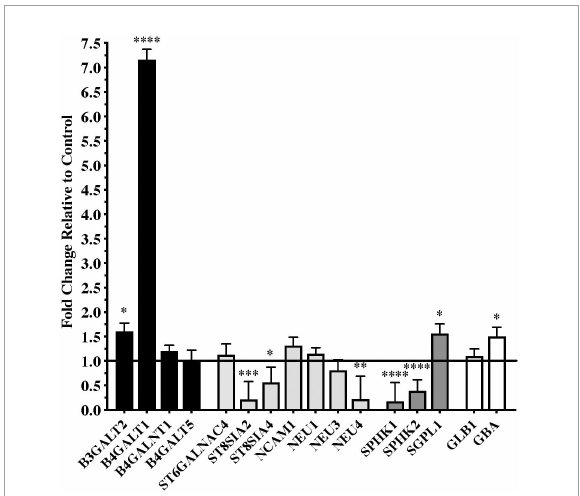
FIGURE1 Gene expression changes in substantia nigra from patients with Parkinson’s disease ( N = 15) relative to normal, age-matched controls ( N = 12). Data are presented as fold change relative to control. Gene expression for glycosyltransferases B3GALT2 and B4GALT1 was significantly higher in patients with PD than in normal controls, while polysialyltransferase genes ST8SIA2 and ST8SIA4 were significantly down-regulated in the PD substantia nigra along with the gene for sialidase NEU4 . Genes involved with sphingodine-1-phosphate (S1P) metabolism were significantly dysregulated in PD substantia nigra with expression of sphingosine kinases necessary for S1P synthesis, SPHK1 and SPHK2 , significantly down-regulated and gene expression for S1P lyase, SGPL1 , involved in the degradation of S1P, was significantly up-regulated. Gene expression for glucosidase beta acid 1 ( GBA ) was also significantly up-regulated in the PD substantia nigra. * P < 0.05; ** P < 0.01; *** P < 0.001; **** P < 0.0001 vs.